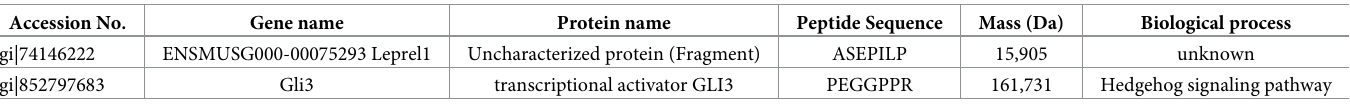
Table 3. Protein identification and functional classification of shared proteins in normal mice treated with cordycepin (N+COR) and diabetic mice treated with cordycepin (DM+COR). Accession No.